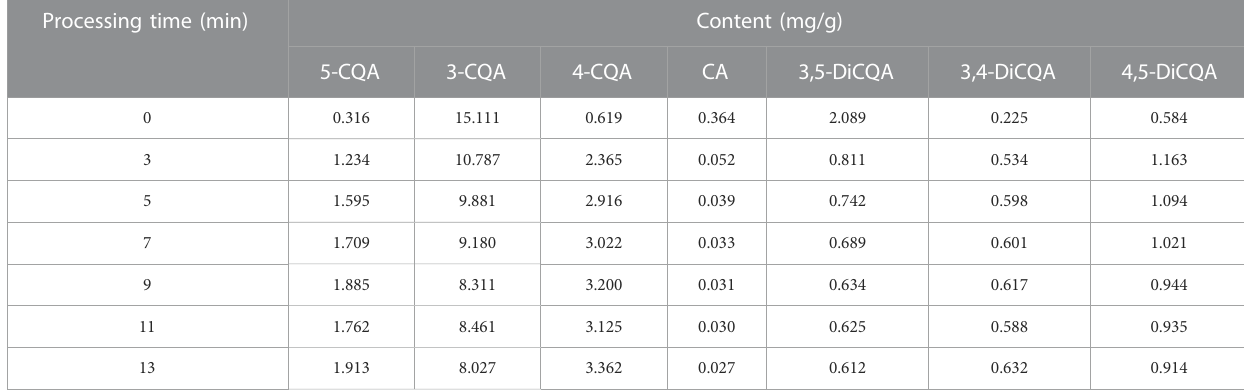
TABLE 4 Content changes of the main compounds in PS during the stir-frying process (150 ° C). Processing time